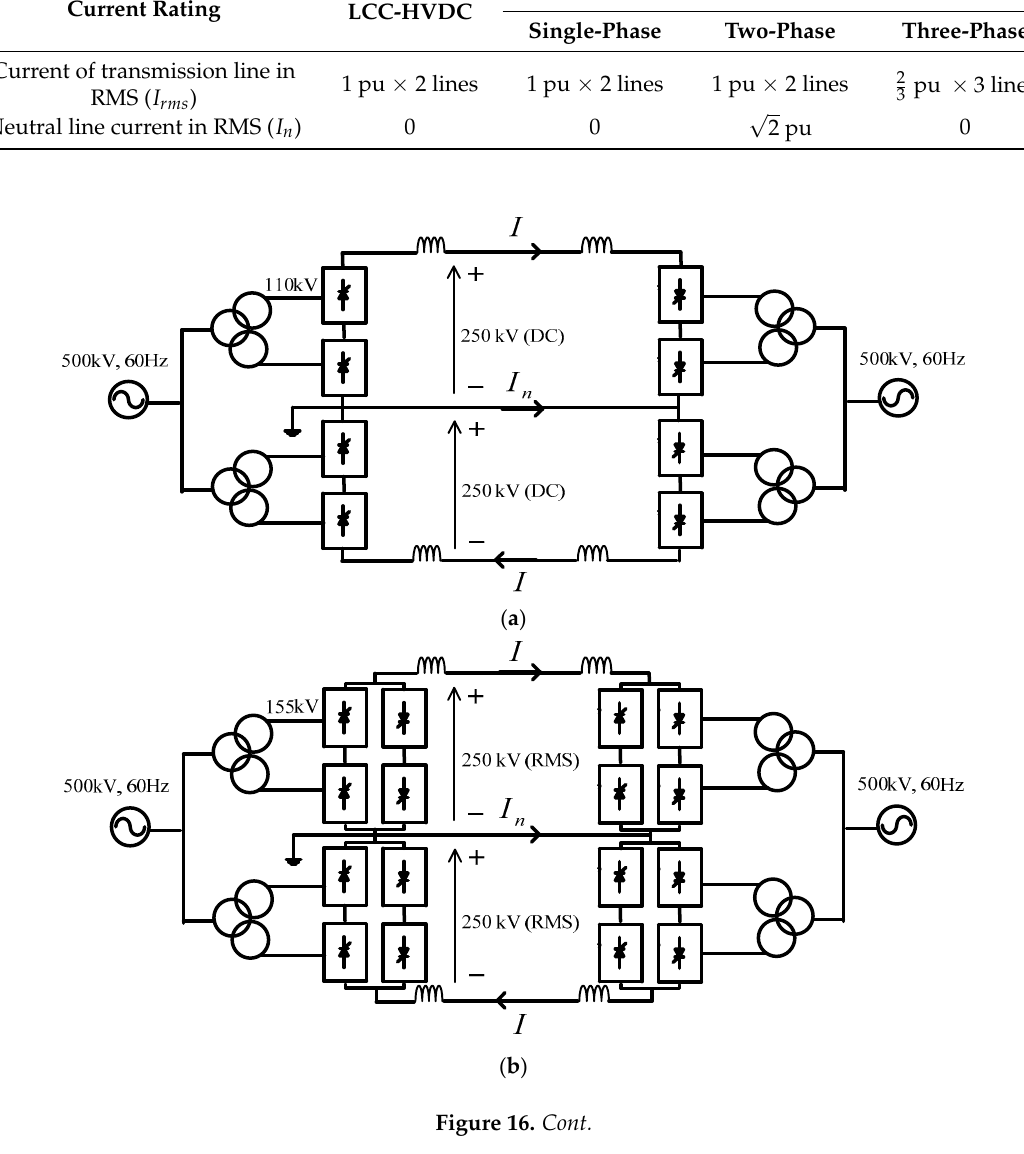
Table 3. Comparison of transmission line rating.